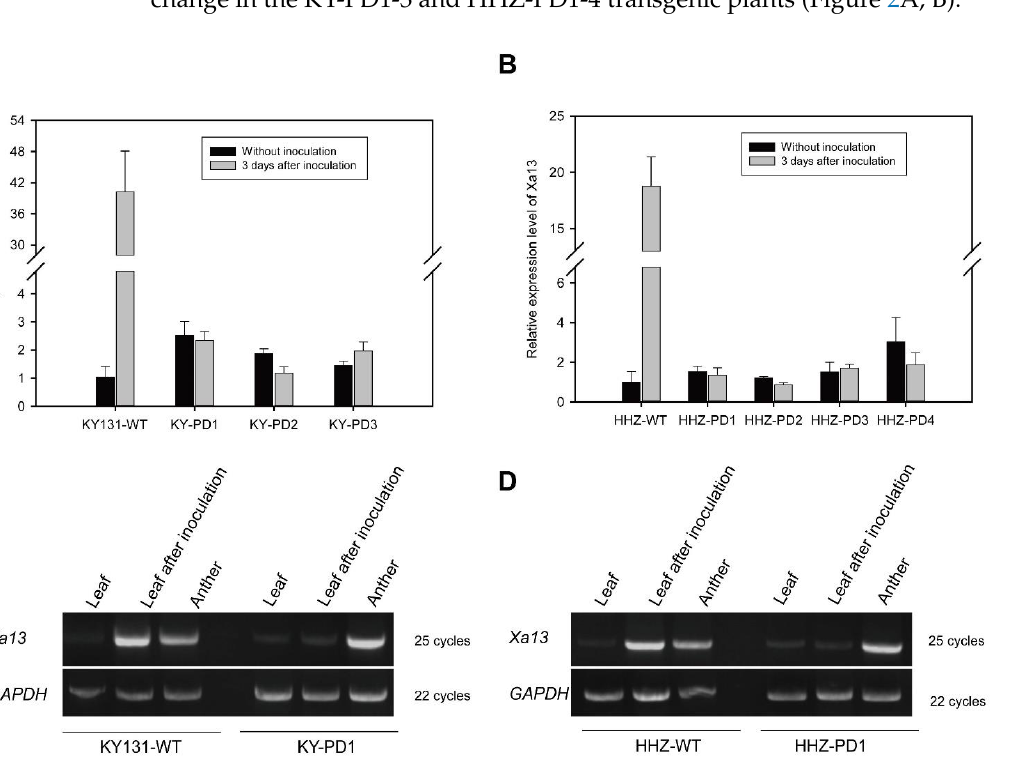
Figure 2. Detection of Xa13 gene expression in T 0 transgenic rice KY-PD1-3 and HHZ-PD1-4. ( A ) qRT-PCR analysis of Xa13 in the leaves of transgenic rice KY-PD1-3 after PXO99 inoculation. Further detection of Xa13 expression by qRT-PCR after inoculation in all T 0 generation lines of KY-PD1-3. After inoculation, expression of Xa13 was upregulated 40 times in the wild-type KY131, but not in transgenic rice KY-PD1-3. ( B ) qRT-PCR analysis of Xa13 in the leaves of transgenic rice HHZ-PD1- 4 after PXO99 inoculation. After inoculation, expression of Xa13 was upregulated 19 times in the wild-type HHZ, but not in transgenic rice HHZ-PD1-4. ( C ) RT-PCR analysis of Xa13 in the leaves and anthers of transgenic rice KY-PD1 by primer X13-Qt1F/R. In the wild-type KY131 and transgenic